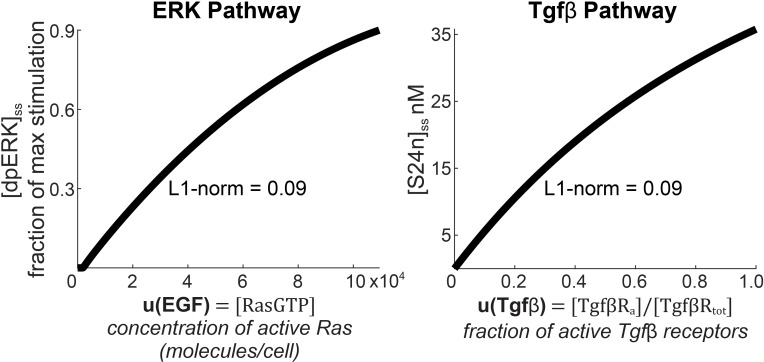
The predicted linearity extends throughout the dynamic range of the ERK and Tgfβ pathways.(A–B) Numerical simulation of the ERK and Tgfβ models. (A) The ERK model shows linear input-output relationship up to 93% of dpERK activation. (B) The Tgfβ pathway shows linear input-output relationship throughout the entire input range (from 0 to 1). Linearity was analyzed using the L1-norm or least absolute deviation (see Materials and methods). The blue range indicates where L1-norm was computed.